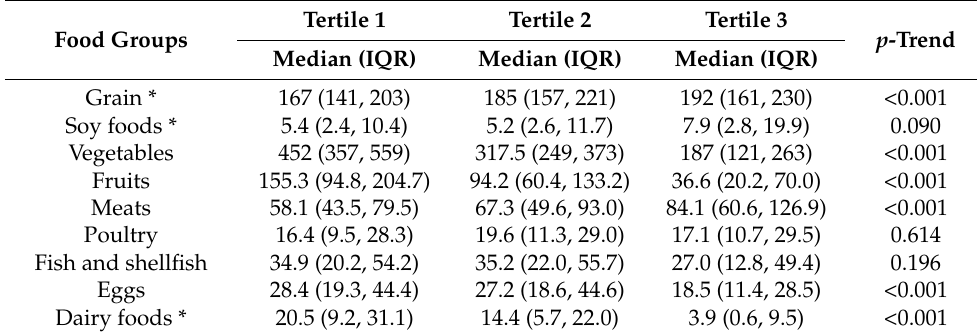
Table 2. Mean (SD) intakes of food groups by quartiles of NEAP in the controls ( n =